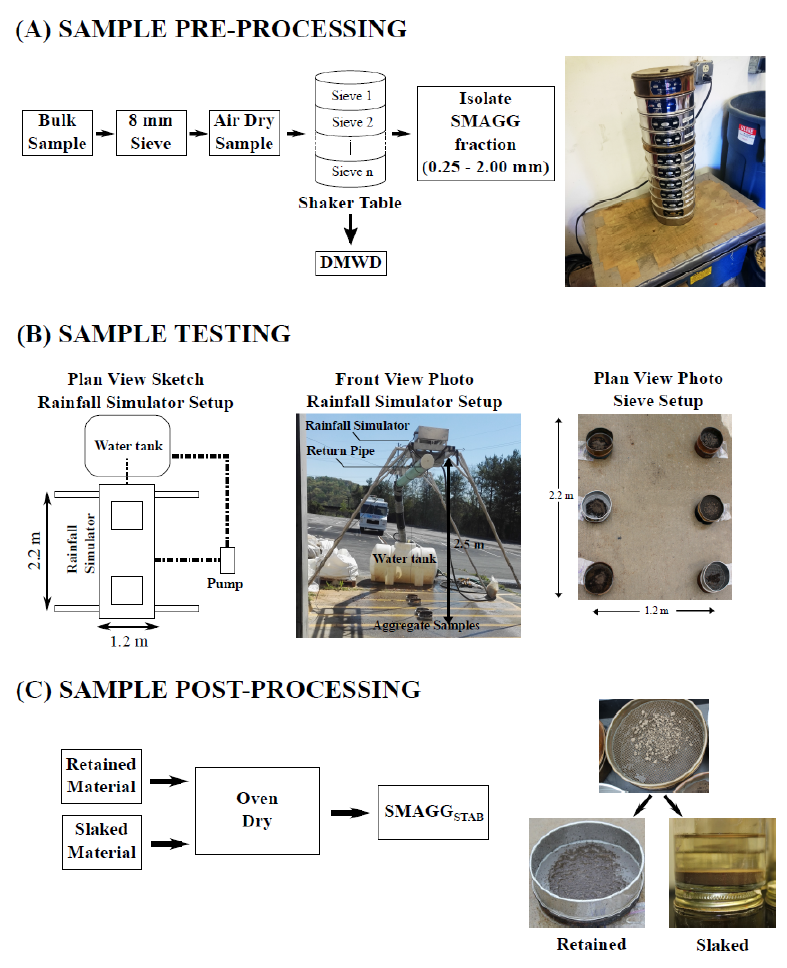
Figure 5. ( A ) sample pre-processing steps to determine the dry mean weight diameter (DMWD) and isolate the small macroaggregate (SMAGG) size fraction to be tested for stability using the rainfall simulator; ( B ) plan view sketch of the rainfall simulator setup, front view photo of the rainfall simulator setup and plan view of the sieve setup for the aggregate stability tests; ( C ) steps followed to quantify SMAGG stability (SMAGG STAB ).